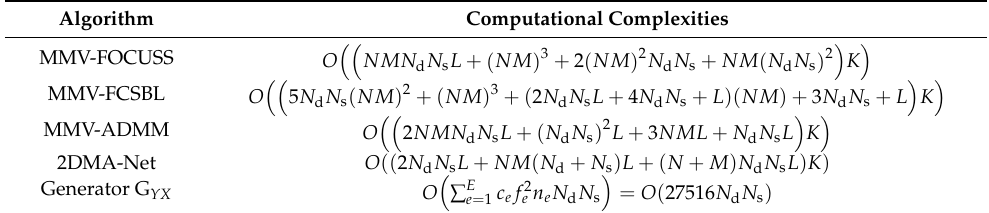
Table 2. Computational complexity of different